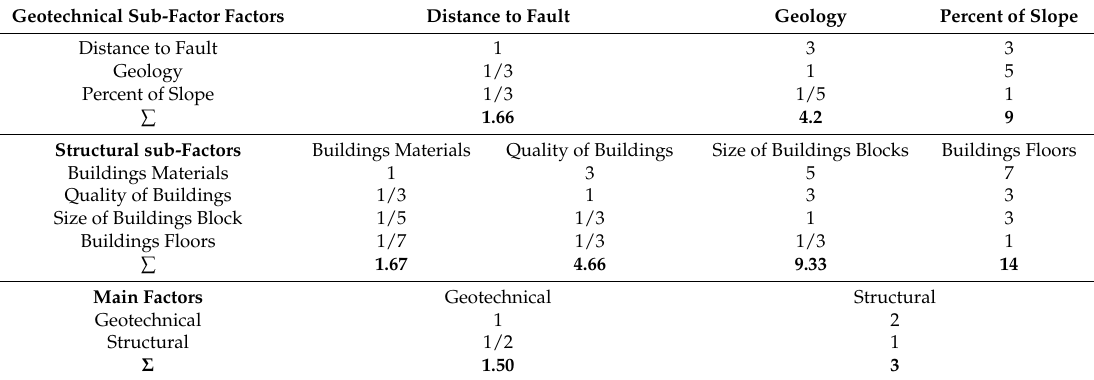
Table 7. Pairwise comparison matrix, sub-factors weights of the data layers.